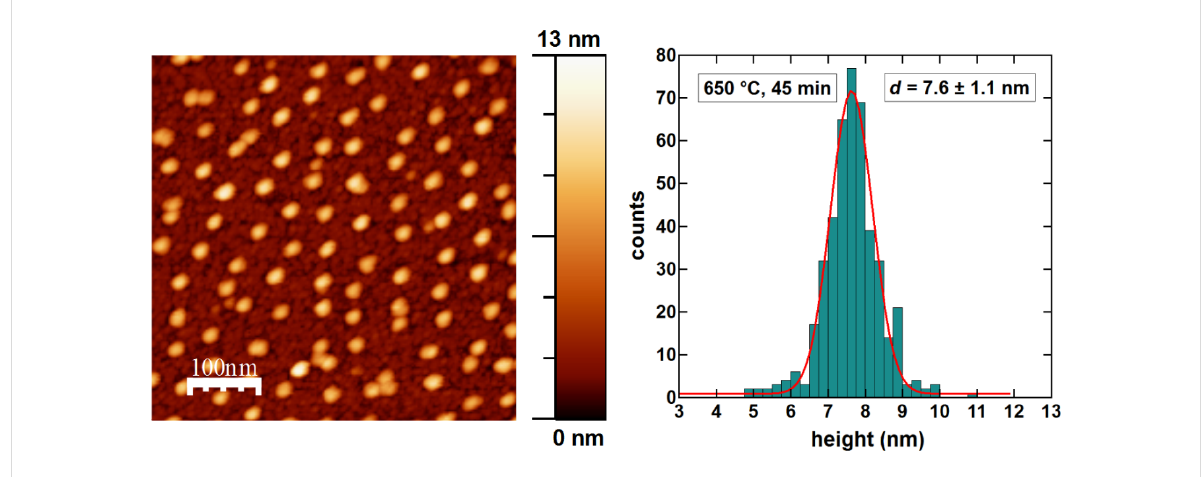
Figure 3: Example of an AFM image (left) and height histogram (right) of micellar FePt NPs on SiO 2 /Si(001) after annealing at 650 °C for 45 min. Compact, well-separated NPs can be observed. The histogram obtained from several AFM images taken at different positions shows a narrow height distribution with an average diameter of 7.6 ± 1.1